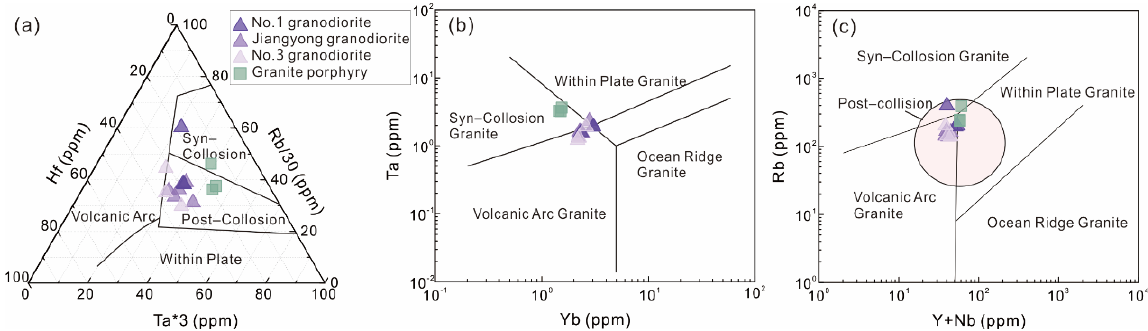
Figure 14. Discrimination diagrams for tectonic settings of formation of granitoids: ( a ) Ta*3–Rb/30– Hf ternary plot (after [103]). ( b ) Y vs. Ta and ( c ) Y + Nb vs. Rb (after [104]). ( a ) Ta*3–Rb/30–Hf ternary plot (after [103]). ( b ) Y vs. Ta and ( c ) Y + Nb vs. Rb (after